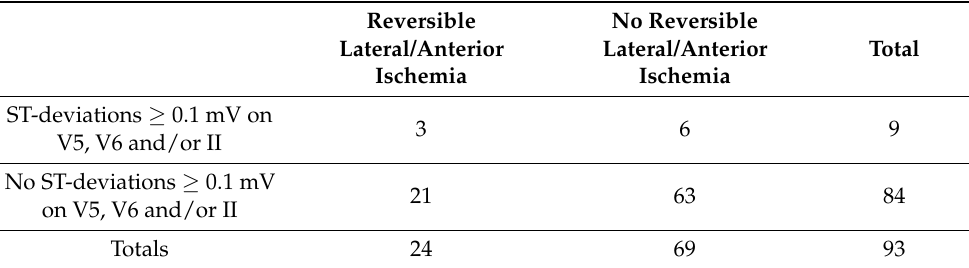
Table 2. 2 × 2 table showing the number of patients with significant ST deviations ≥ 0.1 mV on the 12-lead ECG and how they relate to results from the cardiac-PET divided into reversible anterolateral ischemia or no reversible anterolateral ischemia.